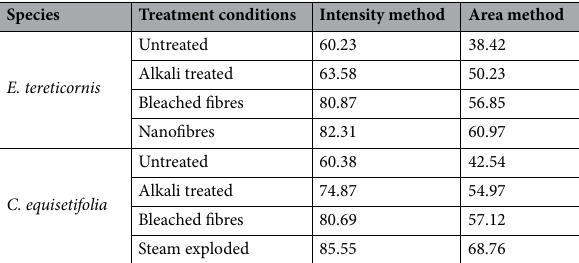
Table 2. Crystallinity index (%) of untreated and treated fibres of E. tereticornis and C. equisetifolia .